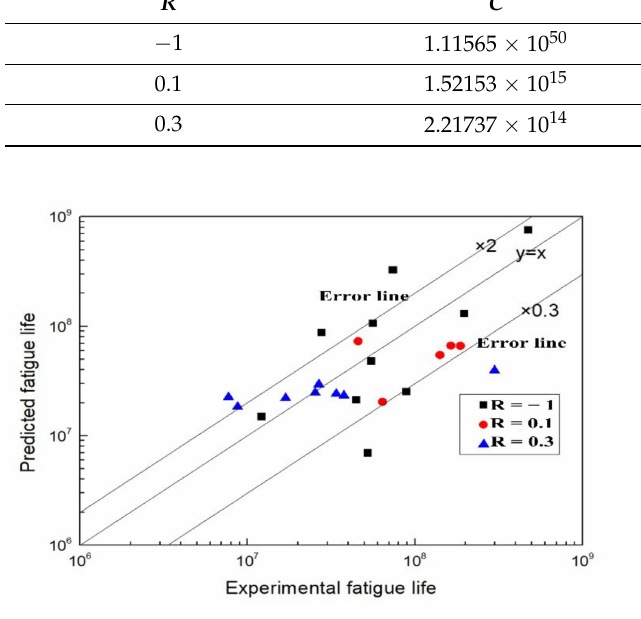
Figure 12. Comparison between predicted and experimental fatigue